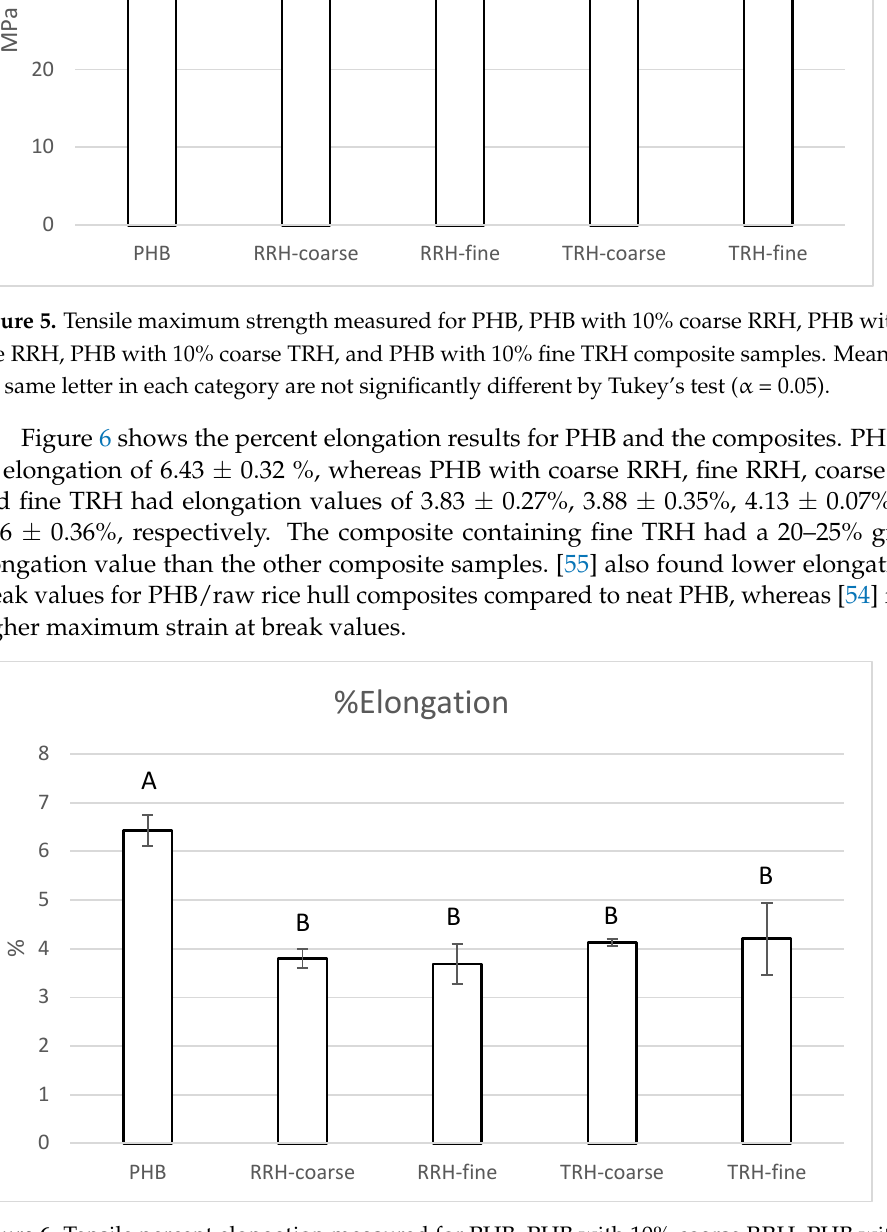
Figure 6. Tensile percent elongation measured for PHB, PHB with 10% coarse RRH, PHB with 10% fine RRH, PHB with 10% coarse TRH, and PHB with 10% fine TRH composite samples. Means with the same letter in each category are not significantly different by Tukey’s test ( α =